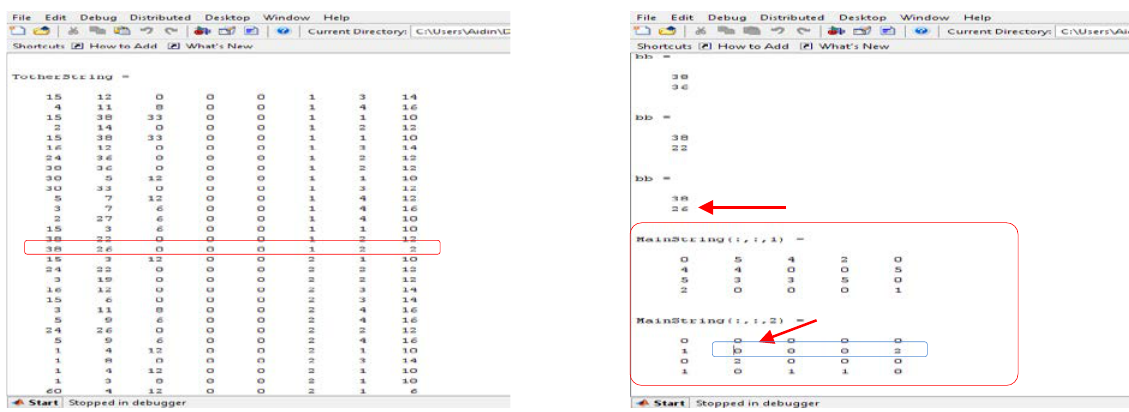
Fig. 7. Using Crossover Operator to choose a part route that still has capacity (left image) and replace it in main string (right